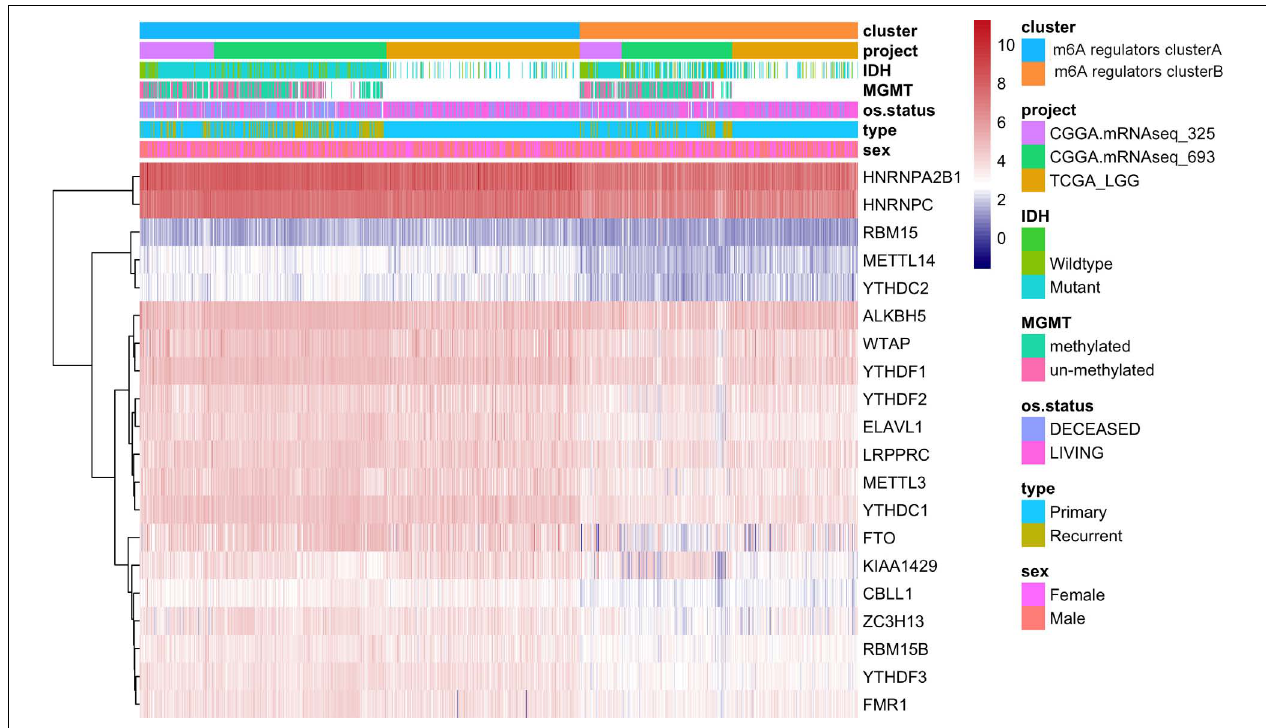
FIGURE 4 | The expression of m6A regulatory factors in m6A regulators